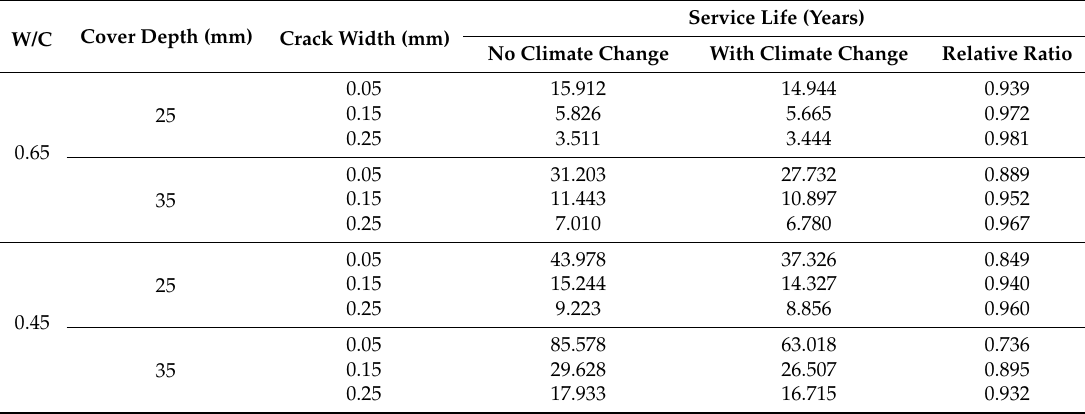
Table 7. Service life of cracked concrete-RCP 8.5 upper 90% confidence interval, time slice 2000.